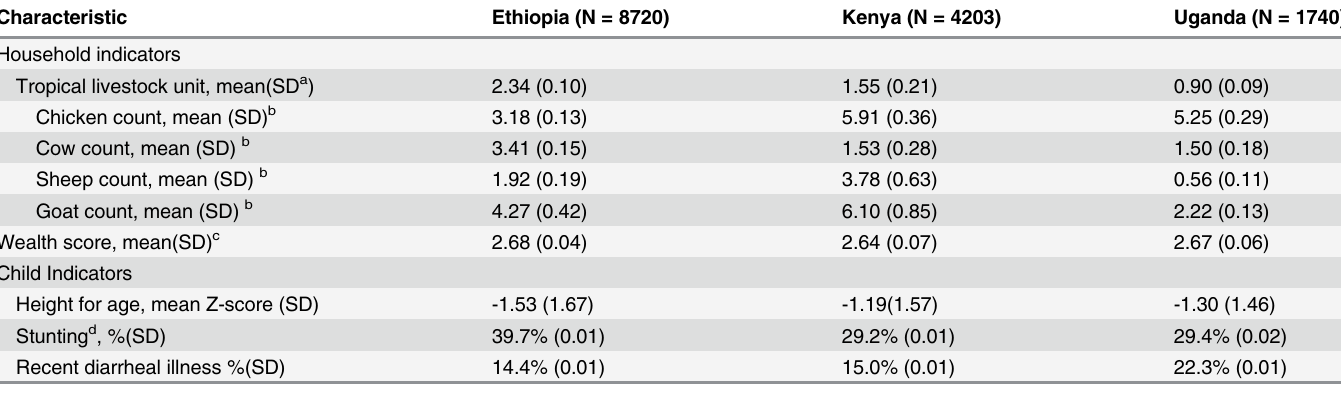
Table 1. Household and child characteristics from Ethiopia 2011, Kenya 2008 – 2009 and Uganda 2010 Demographic and Health Surveys (DHS). Characteristic Uganda (N =